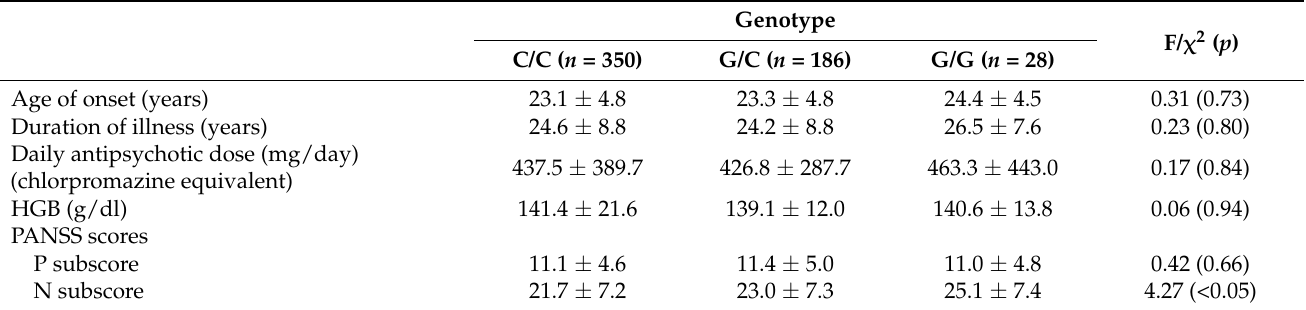
Table 2. Clinical characteristics of patients in the rs3811655 genotype